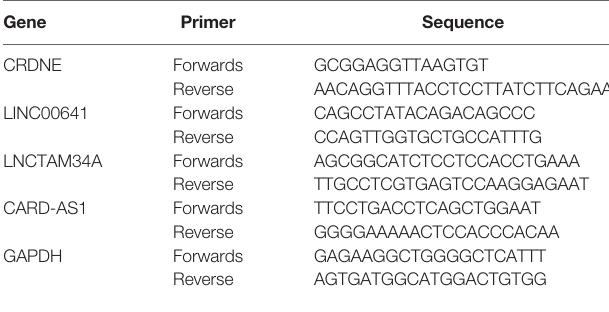
TABLE 3 | Sequences of